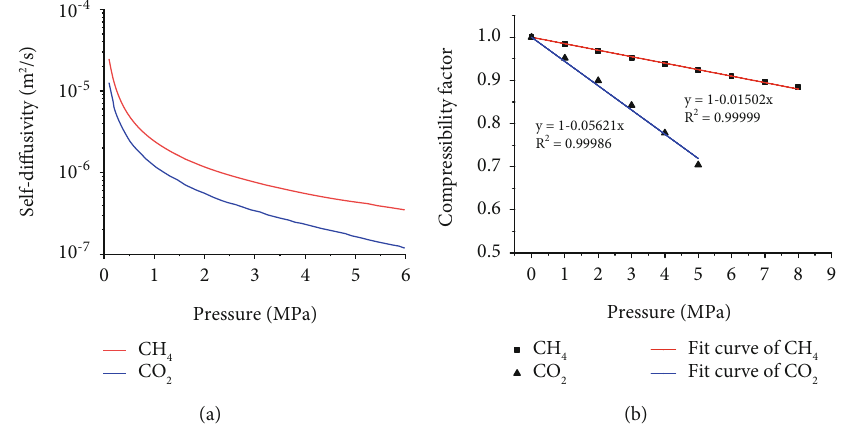
Figure 6: Pressure-related parameters of gas. (a) The relationship between self-di ff usivities and pressure [35]. (b) The relationship between compressibility factor and